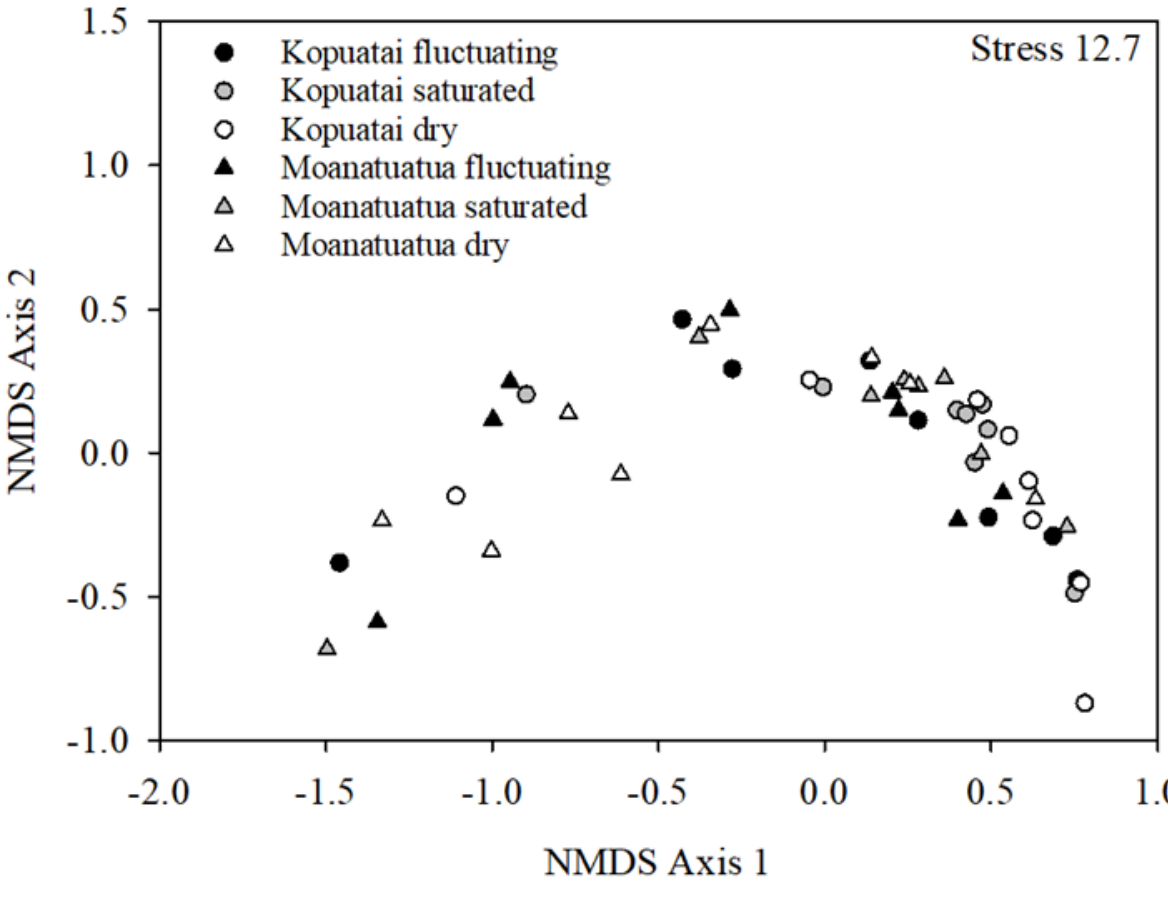
Figure 3. Two-dimensional non-metric multidimensional scaling (NMDS) plot of community-level physiological profiles in the dry, fluctuating and saturated zones at the Kopuatai and Moanatuatua peatlands. The stress value is a